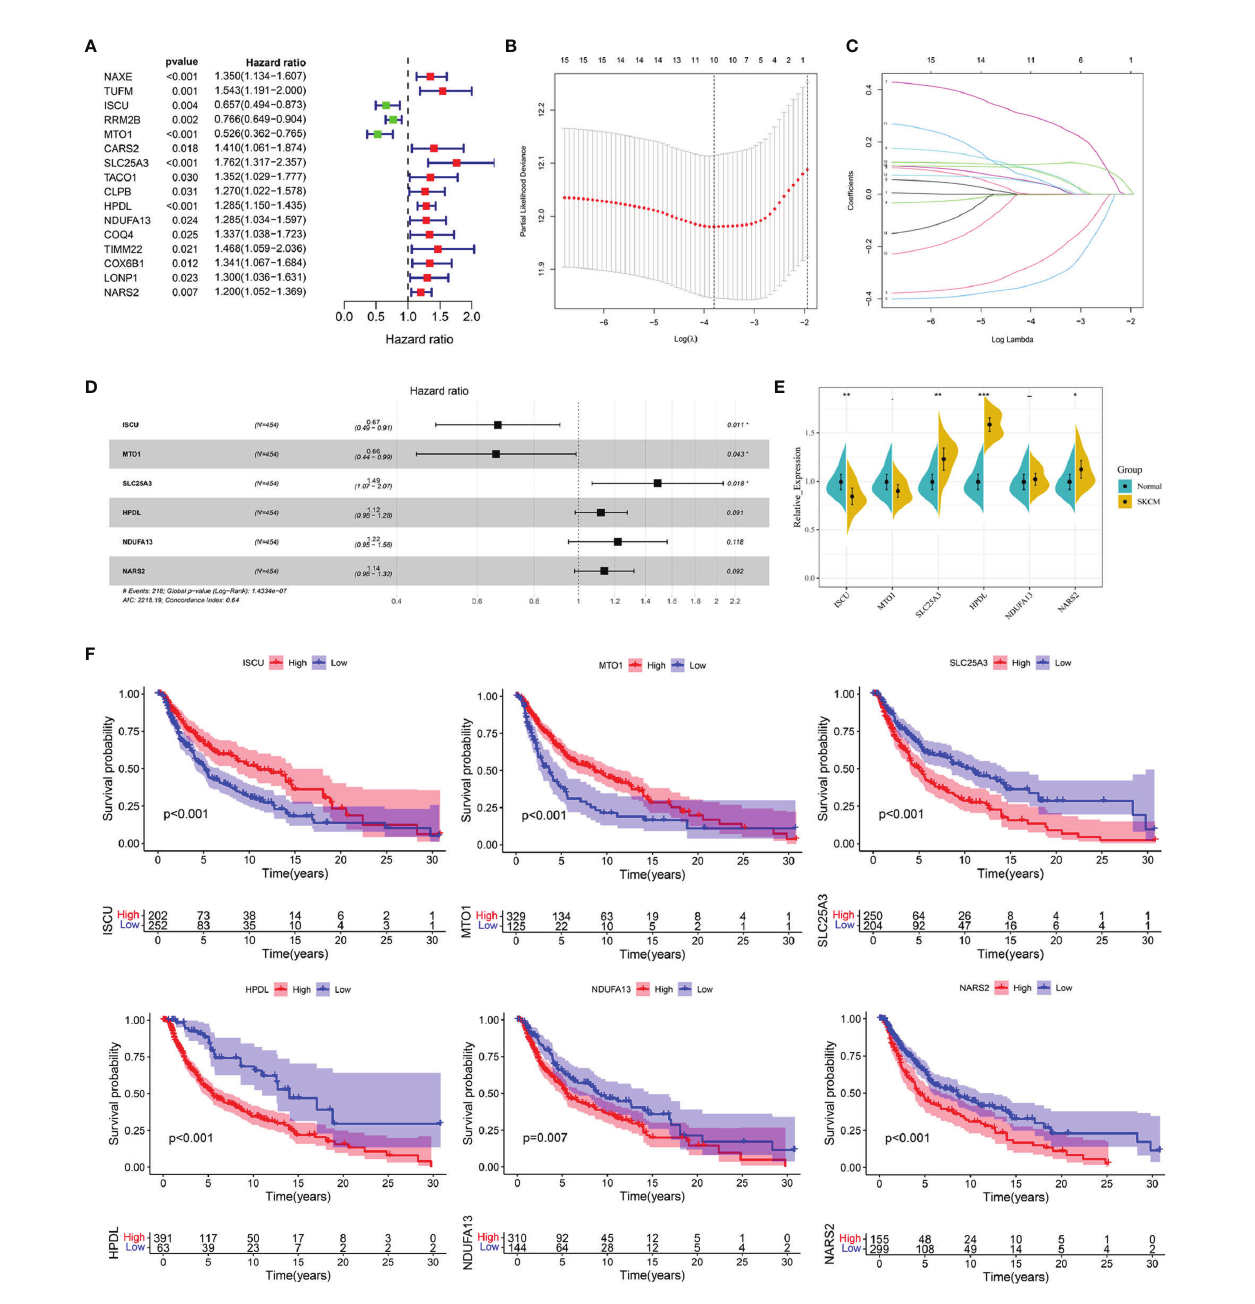
FIGURE 4 | Construction of the LRG prognostic signature in TCGA cohort. (A) Identi fi cation of the prognosis-related differentially expressed LRGs by univariate Cox regression analysis. (B, C) LASSO Cox regression analysis of 16 prognosis-related differentially expressed LRGs. (D) Forest plot of the six target genes that compose the LRG signature. (E) The expression levels of six target genes by qRT-PCR. (F) The Kaplan Meier analysis of the six target genes *P < 0.05; **P < 0.01; ***P <